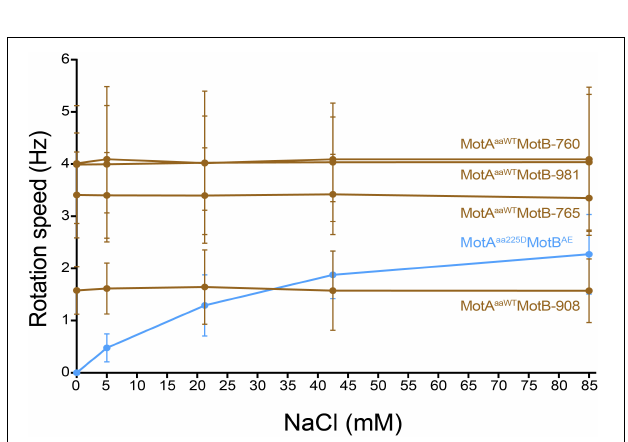
FIGURE 7 | Tethered cell rotational speeds of MotA aaWT MotB-ASRs vs. extracellular concentration of Na + . Rotational speed measured by tethered cell for varying extracellular concentrations of Na + showed that the four A. aeolicus compatible MotB-ASRs rotated independently of external concentration of Na + (MotB-ASR908, MotB-ASR765, MotB-ASR981, MotB-ASR760, dark brown colored lines). This is in contrast to the control sodium-motile A. aeolicus point mutant MotA in combination with A. aeolicus-E. coli chimeric MotB (MotA aa 225 D MotB AE , blue